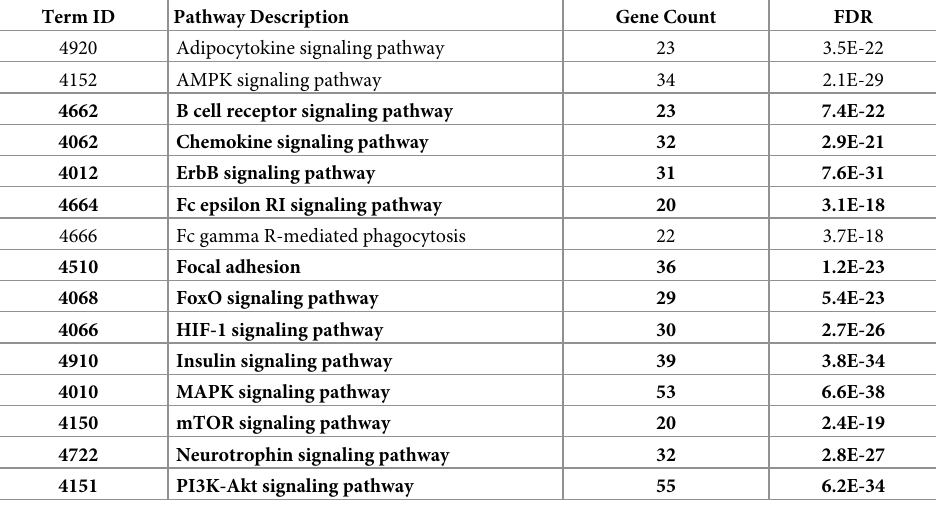
Table 3. Top 15 KEGG signaling pathways in the ileum.